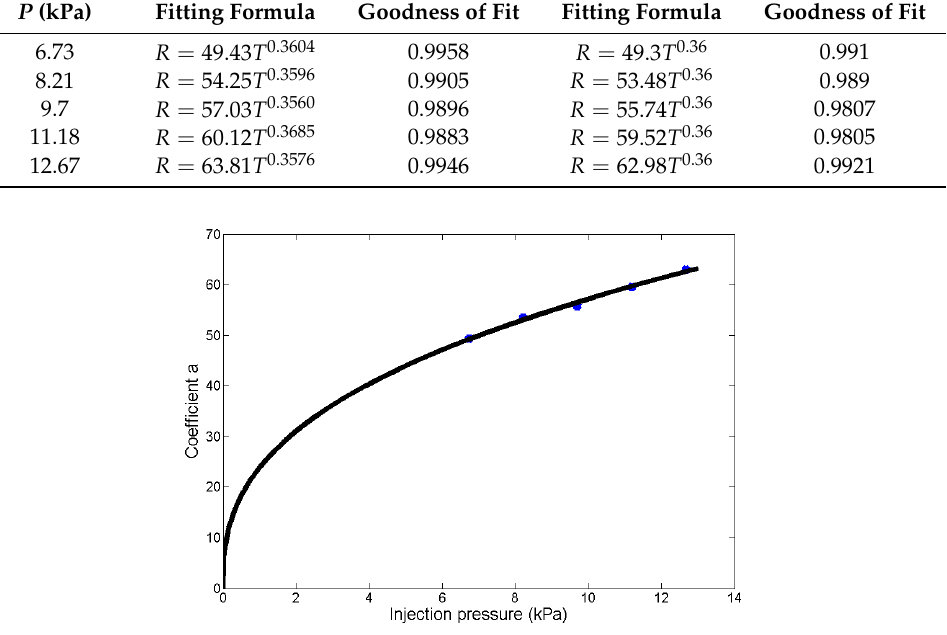
Figure 7. The coefficient a follows the power law versus injection pressure (the blue points), which is fitted with Equation (5) (the black curve), with a goodness of fit of 0.99.